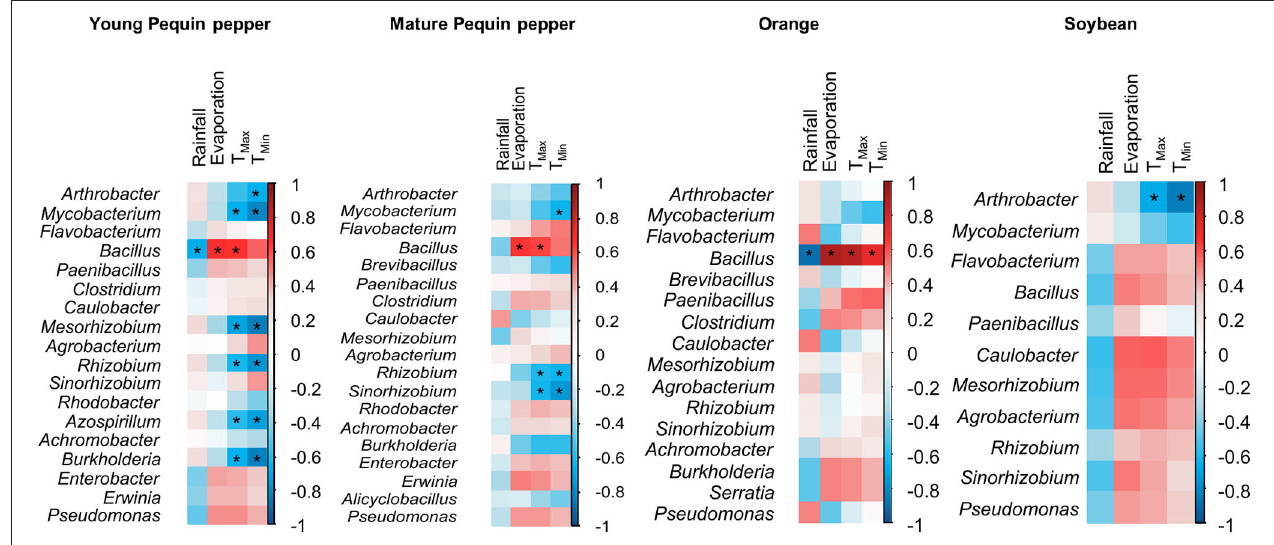
FIGURE 8 | Plant growth promoting rhizobacteria (PGPR) correlated with climatological parameters. Correlation matrix was constructed using Pearson lineal correlation method. “*”: significant correlation ( P ≤ 0.05). Red and blue color represents positive and negative correlation, respectively. + 1 means a perfect positive correlation and − 1 means a perfect negative correlation. Rainfall, Evaporation, Tmax and Tmin are the climatic variables measured at the climatological station located at 2km from the experimental field during